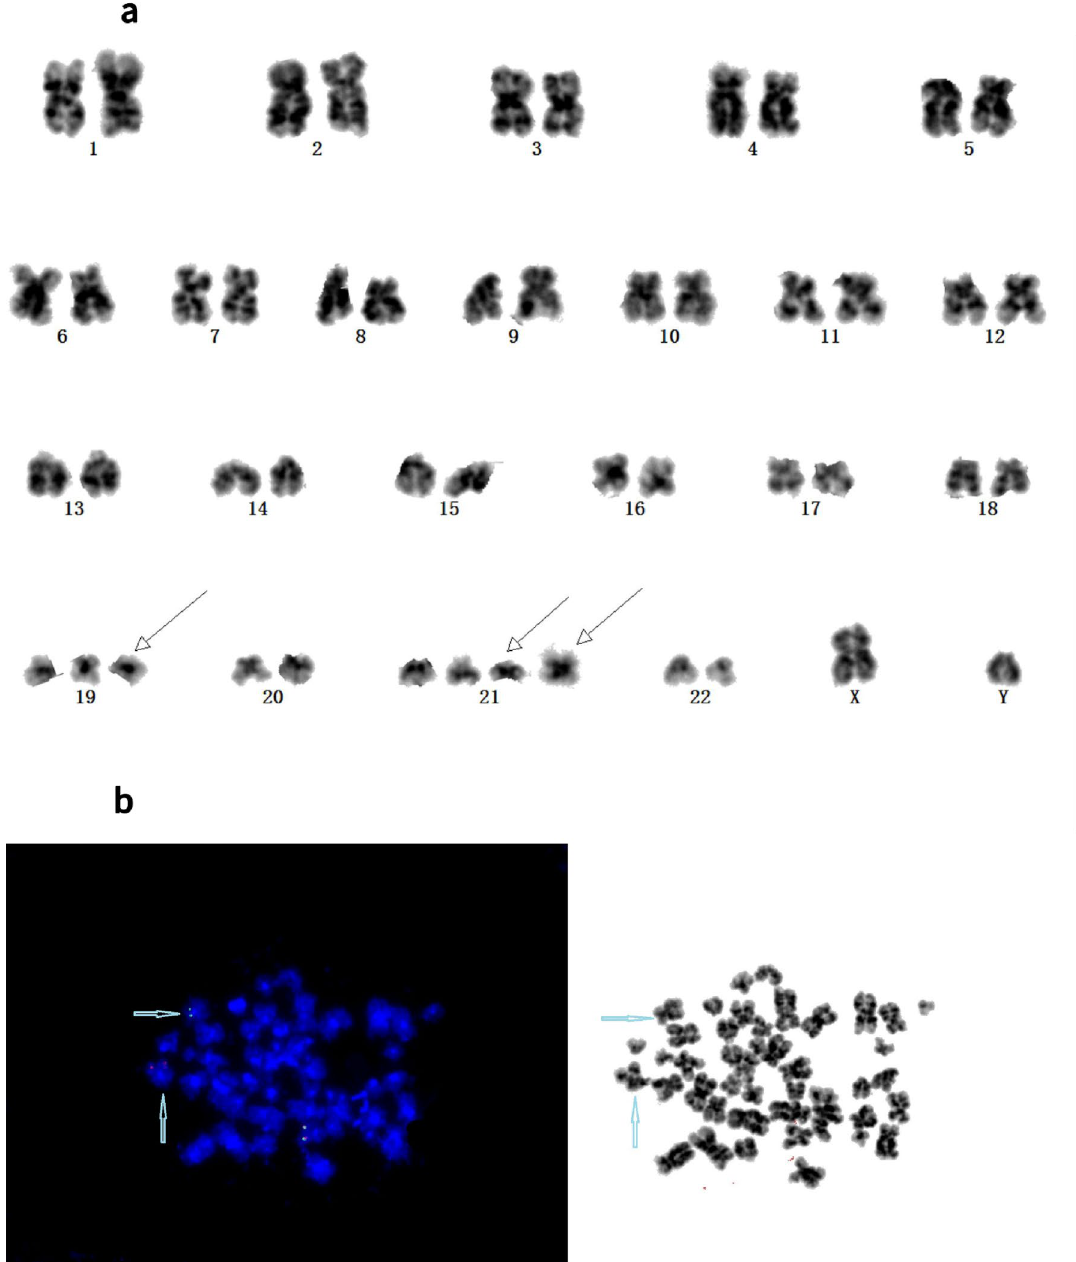
Figure 2. ( a ) Karyotype of Patient 1 showing 49,XY, + 19, + 21, + add(21)(p10). ( b ) Metaphase fluorescence in situ hybridization (FISH) analysis of patient 1 using the KMT2A probe, with chromosome 11 presenting a normal KMT2A gene signal (fusion-yellow FISH signal), a translocation presenting splatted signals, a green KMT2A signal in the short arm of a derivative chromosome 10, and an orange signal indicating the long arm of derivative chromosome 11 (blue